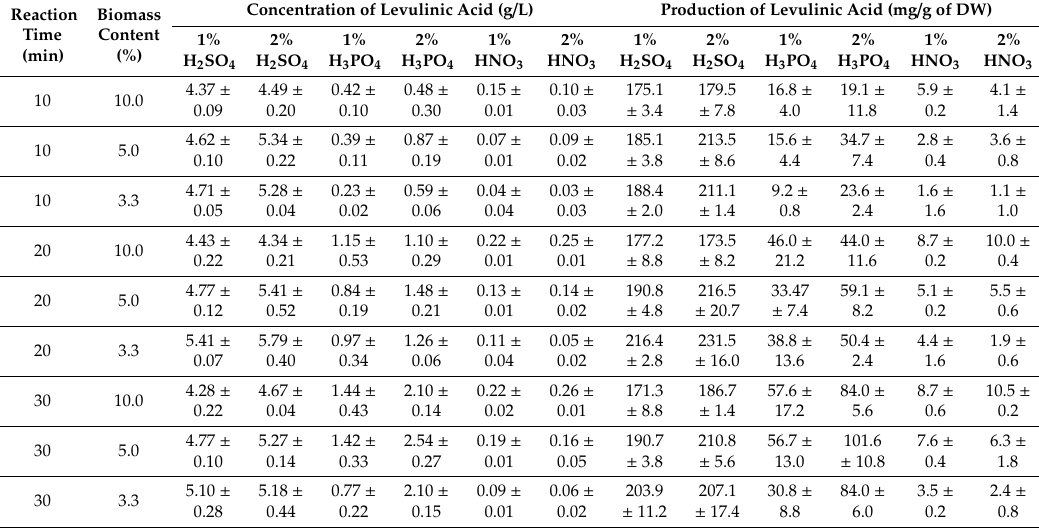
Table 1. Influence of reaction time, biomass content, concentration and type of inorganic acid on microwave-assisted production of levulinic acid from pine